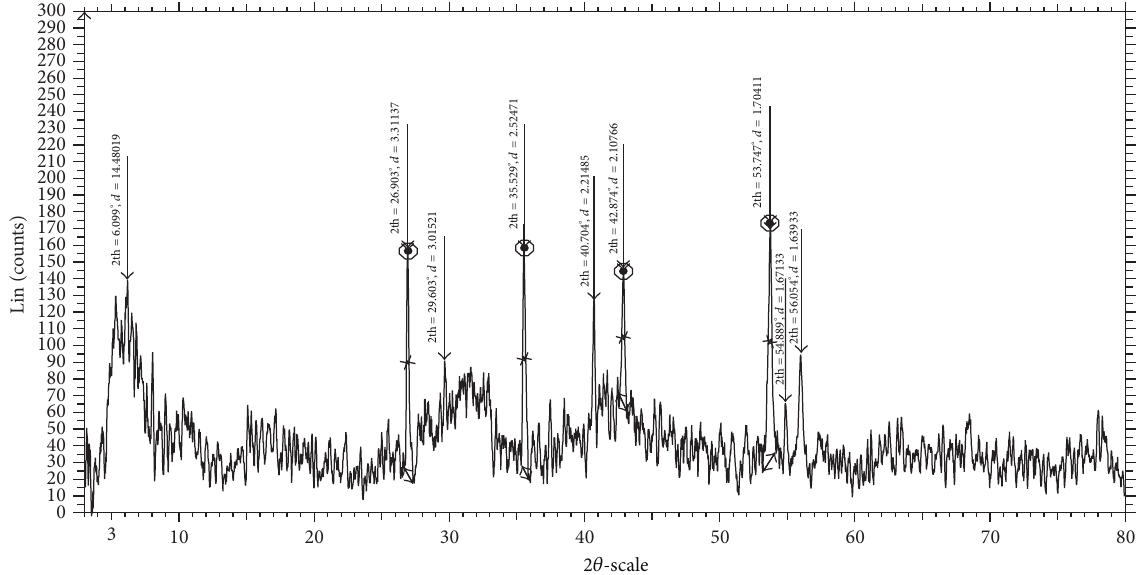
Figure 6: Powder XRD spectrum of Ni(II) complex.